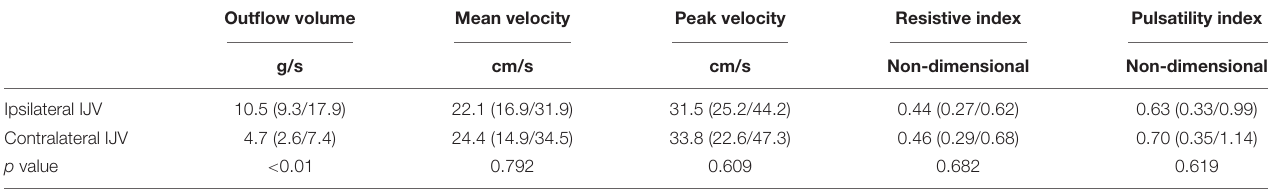
TABLE 4 | Results of bilateral internal jugular vein hemodynamics of 19